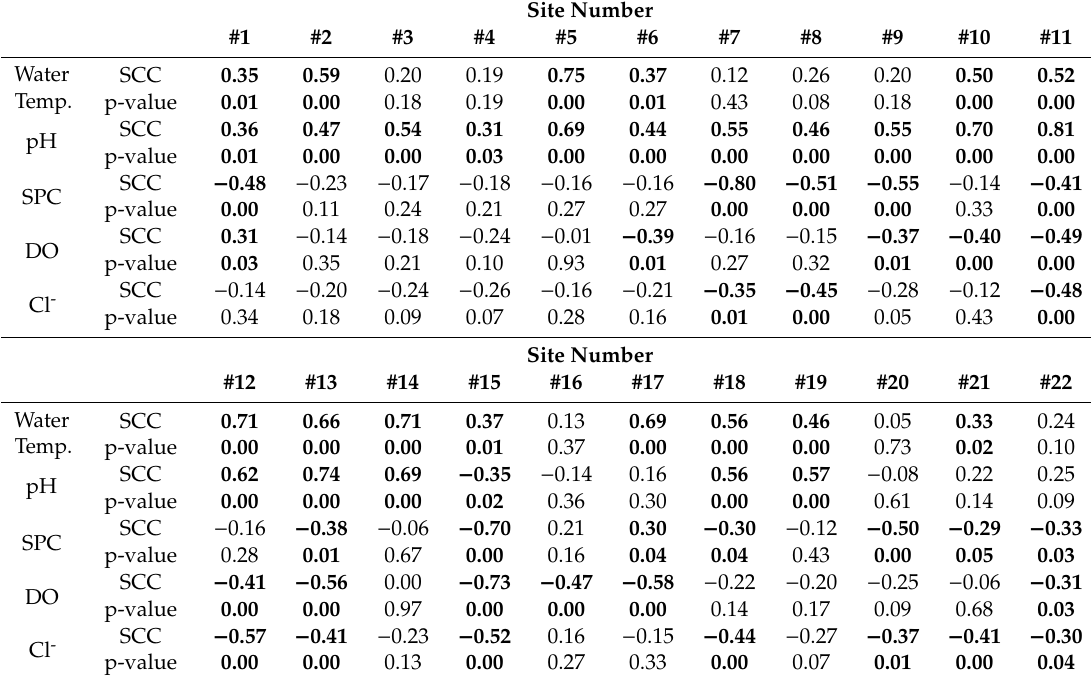
Table 2. Results of Spearman’s Correlation test, including annual E. coli concentration (colony